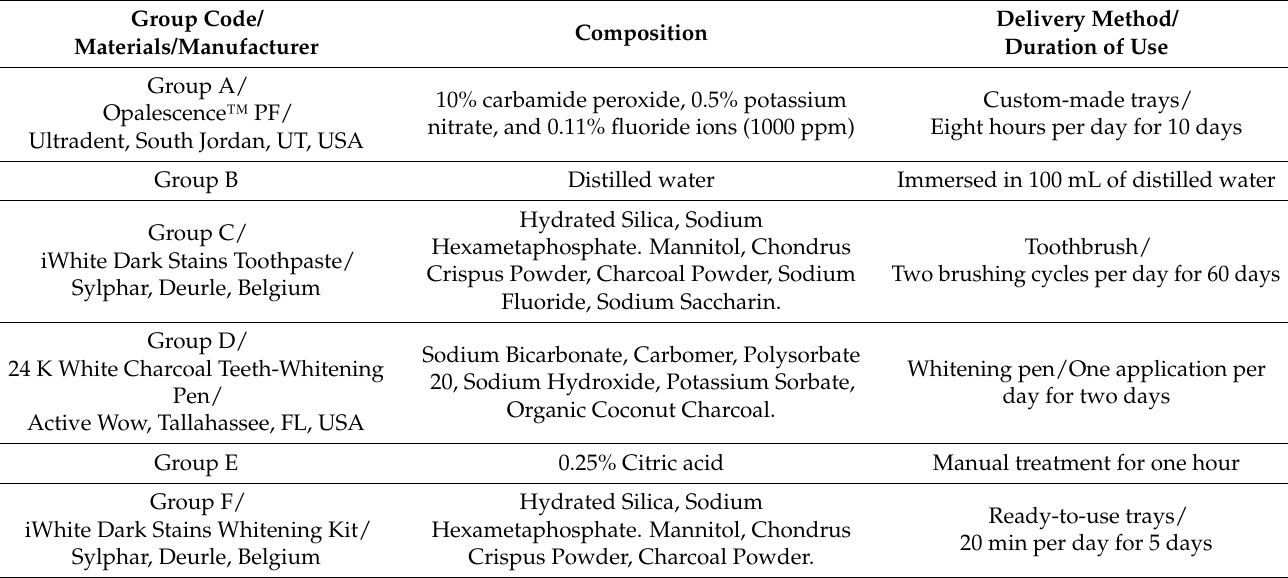
Table 1. Materials and group coding used in the